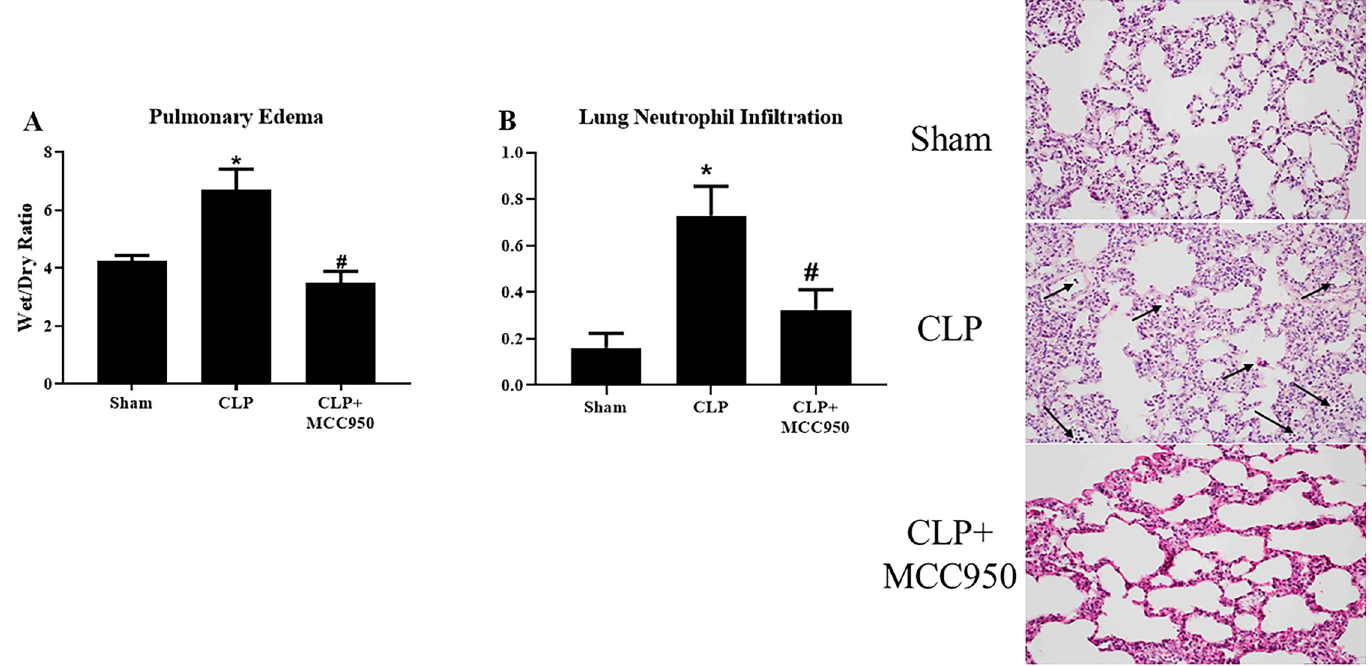
Fig 6. Lung injury. Pulmonary injury in response to CLP. Lung wet/dry weight ratio ( A ) and Neutrophil Infiltration (arrows) into pulmonary tissues ( B ) were assessed in Sham, CLP, and CLP+MCC950 rats. Representative images of hematoxylin and eosin (H&E) staining ( B ). ( n = 11/group). � p < 0.05 vs Sham, #p < 0.05 vs CLP.